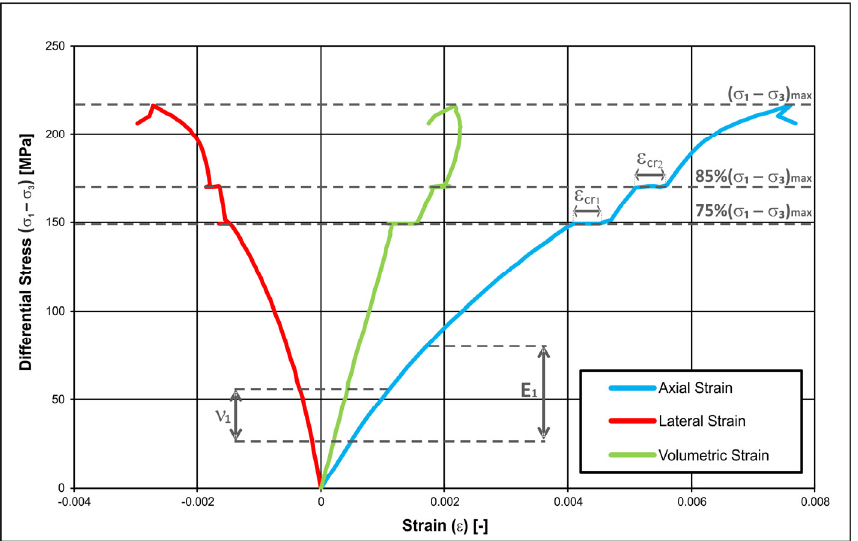
Figure 7. Characteristics of differential stress–axial, lateral and volumetric strain obtained from the brittle creep test for sample M-43-A.